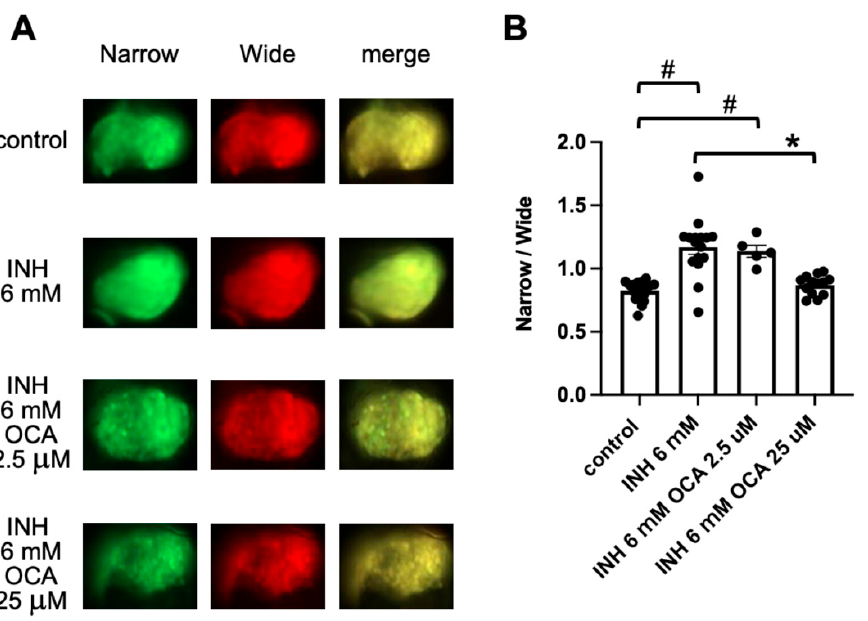
Figure 4. Assessment of hepatic apoptosis in Tg (pck1:Casper3GR) treated with INH with and without OCA. ( A ) Representative in vivo fluorescence images of Tg (pck1:Casper3GR) treated with INH with and without OCA from 4 to 5 dpf. Images acquired using narrow and wide filters and merged images are shown. ( B ) Hepatic apoptosis was assessed as the ratio of narrow and wide areas of fluorescence above the threshold in the liver of zebrafish at 5 dpf treated with INH with and without OCA. Circles represent individual zebrafish, and bars represent the group means with standard error of the means. n = 18, 16, 5, and 13 for control, INH 6 mM, INH 6 mM OCA 2.5 μ M, and INH 6 mM OCA 25 μ M, respectively. # p < 0.05 vs. control, * p < 0.05 vs. INH 6 mM.